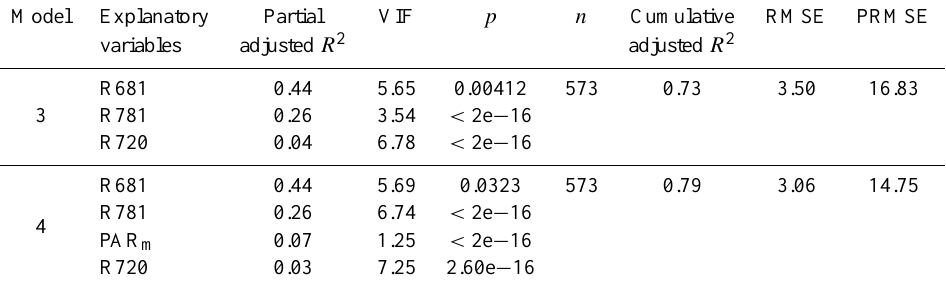
R781 0.26 < 2e − 16 PAR m 0.07 1.25 < 2e − 16 R720 0.03 2.60e −